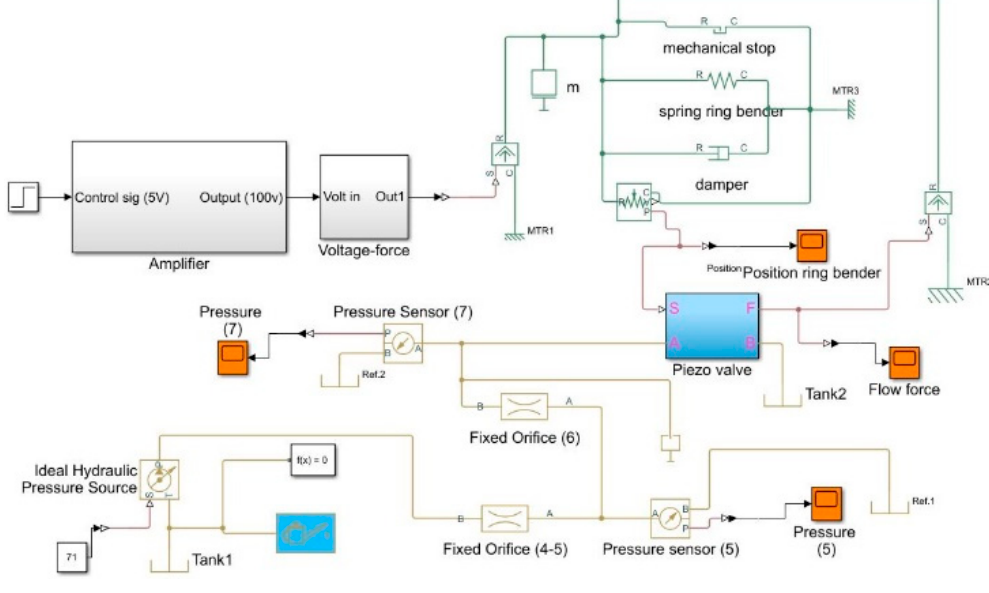
Figure 4. Simscape model employed for the numerical analysis.